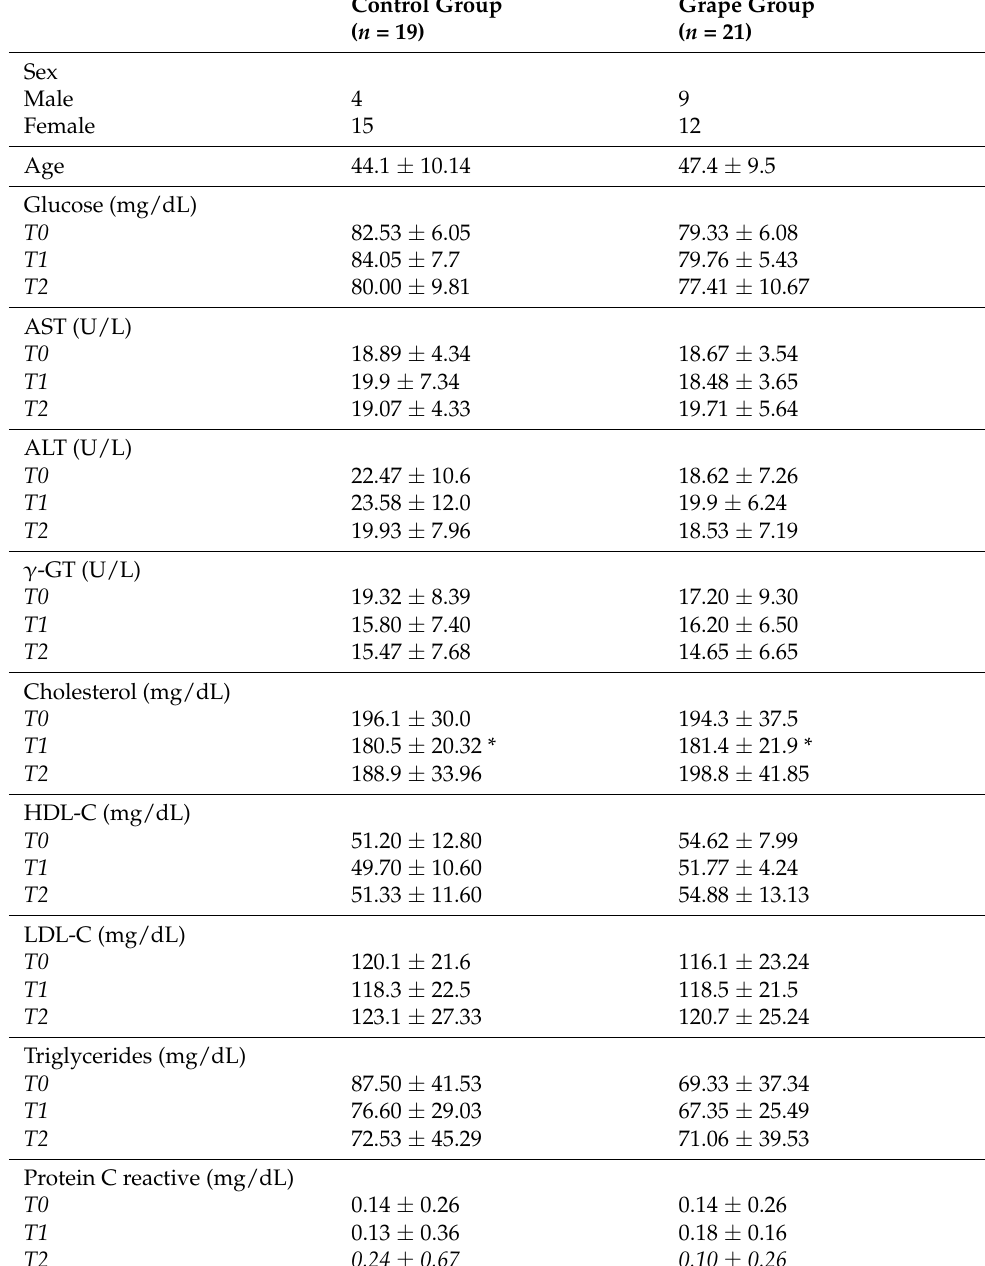
Table 1. Clinical and Biochemical Characteristics of Participants at T0 (Baseline), T1 (Day 21), and T2 (Day 49).